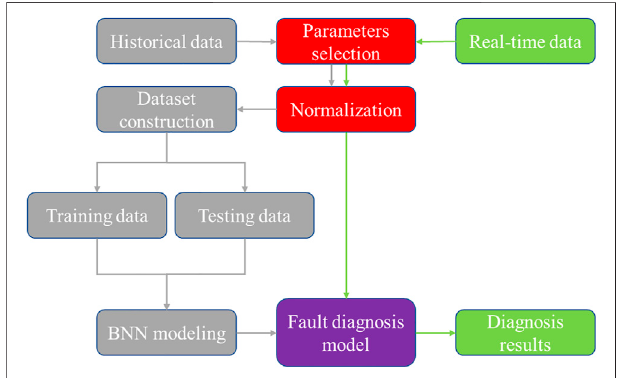
FIGURE 3 | BNN fault diagnosis